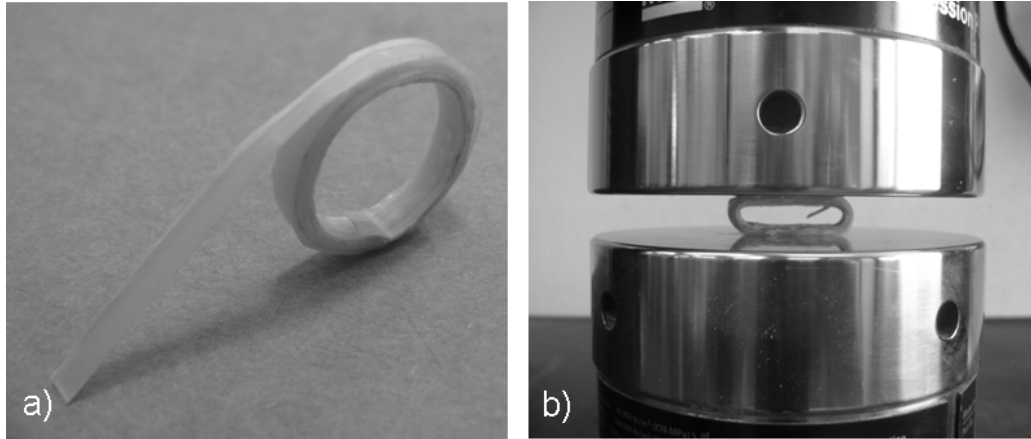
Figure 5. (a) Wound composite at the end of the consolidation process and (b) during